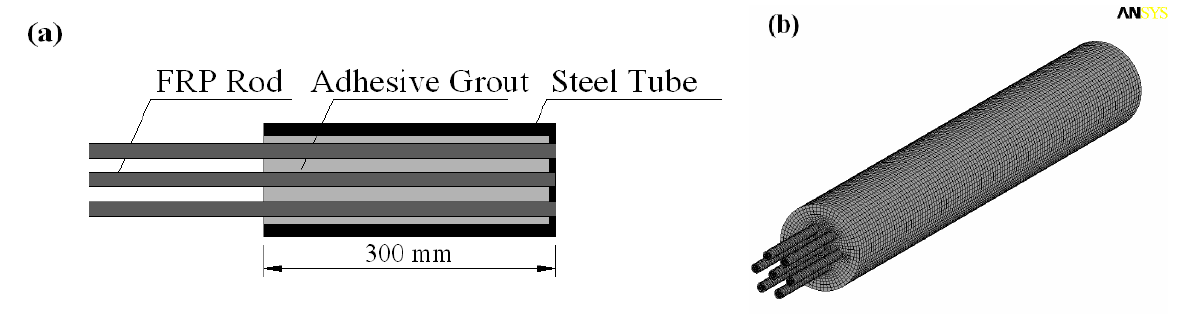
Figure 6. ( a ) Numerical model of a seven-rod anchor; ( b ) meshed finite element model.